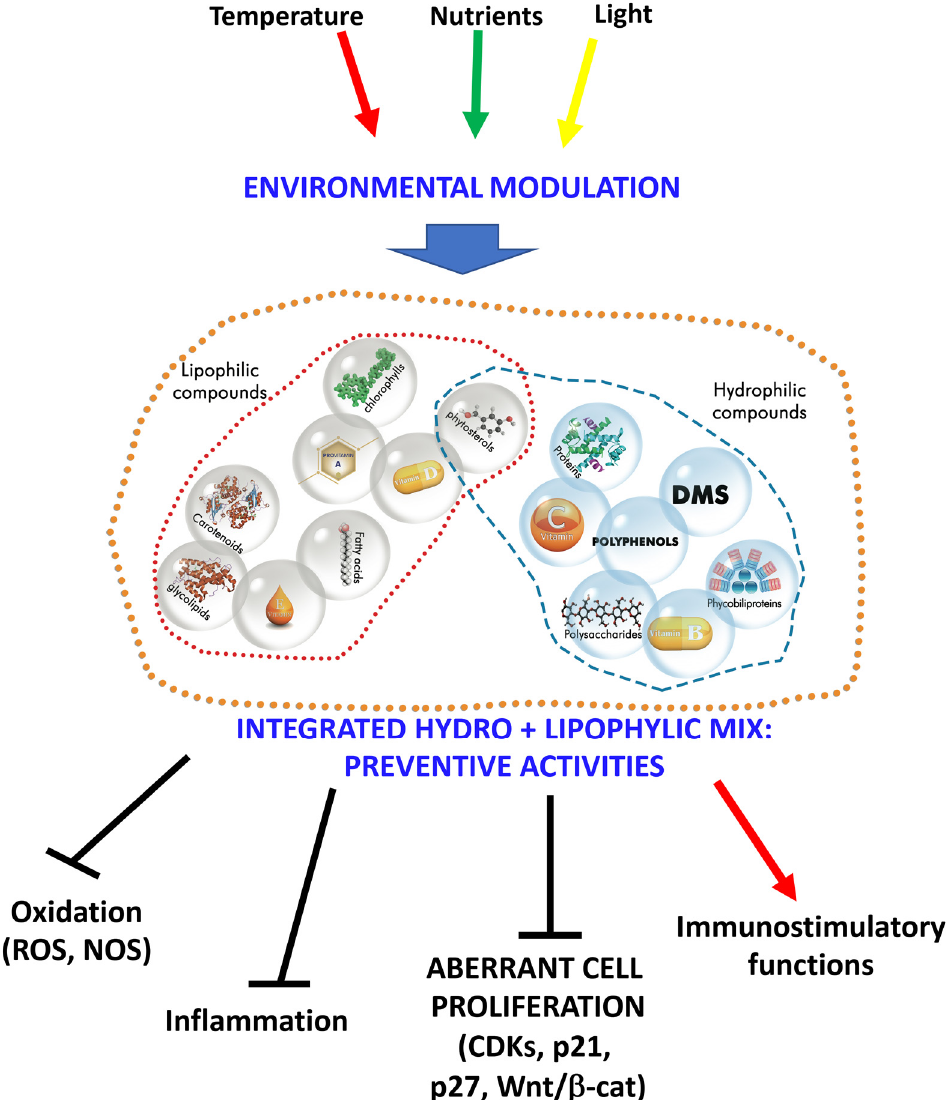
Figure 1. Diversity of bioactive compound families with potential chemopreventive e ff ects present in microalgae as a candidate for food supplements. The hydrophilic and lipophilic compounds’ groups are distinct. In order to provide a wide range of protective e ff ects, the synergy between groups of molecules is required. This can be obtained with a two-step process (mixing the two hydro- and lipophilic extracts [37,38] or in one step process [39]. The combinations proposed will result in enhanced preventive activities action by blocking oxygen (ROS) / nitrogen (NOS) reactive species generation, inflammation, aberrant cell proliferation (such as cancers) and by potentiating the activities of the immune system (immunostimulatory functions). DMS: dimethylsulfide, ROS: oxygen reactive species; NOS: nitrogen reactive species; CDKs: cyclin-dependent-kinases.